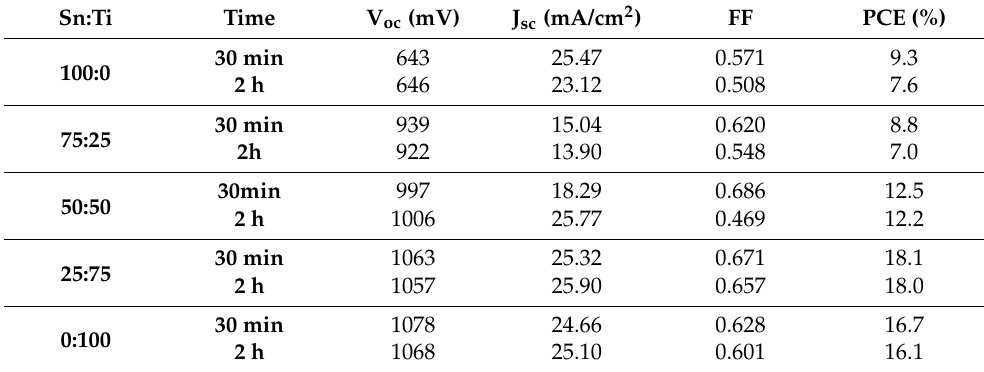
Figure 8. I–V curves of the best-performing devices by Sn/Ti oxide ETLs measured under simulated sunlight. The period of maximum temperature in the sintering of ETL was 30 min. Table 1. I–V parameters obtained for the best-performing perovskite solar cell fabricated using the ETLs with different ratios of Sn/Ti and sintering times.